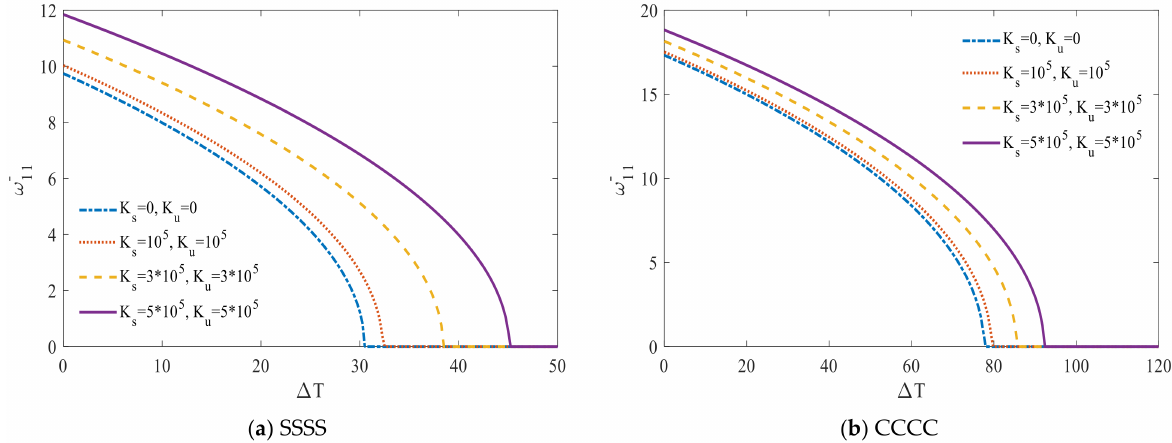
fractions ( a = b , a / h = 25, and GPL-X).